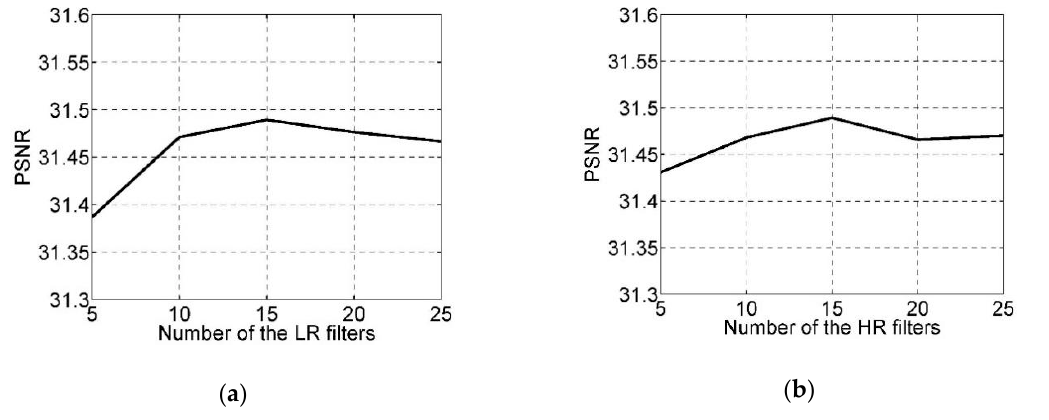
Figure 3. The impacts of the number of the filters. ( a ) K L . ( b ) K H .